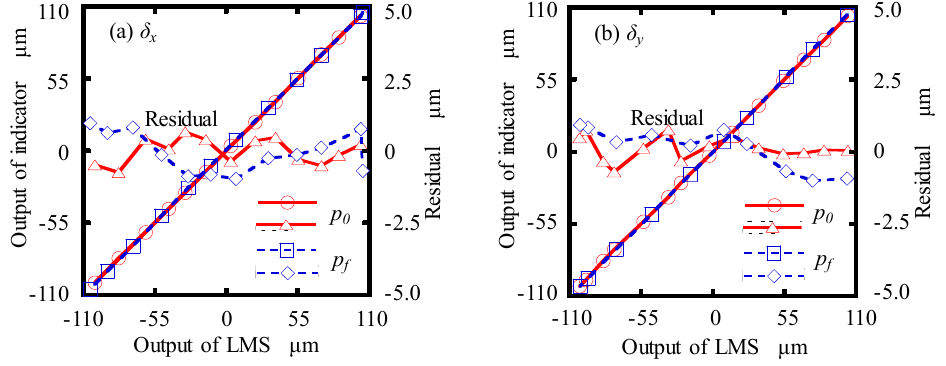
Figure 7. Calibration results of: ( a ) δ x ; ( b ) δ y .